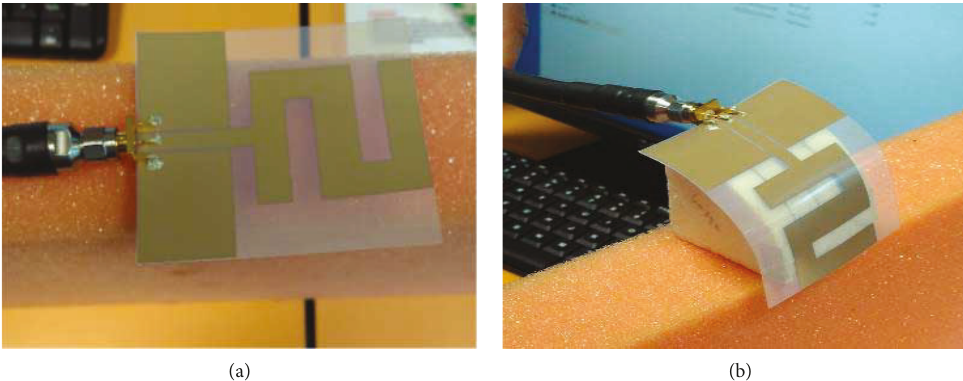
Figure 6: Fabricated Z-shape antenna by the proposed inkjet printer technique on the PET substrate. (a) Flat condition. (b) Bending condition (radius: 40 mm).